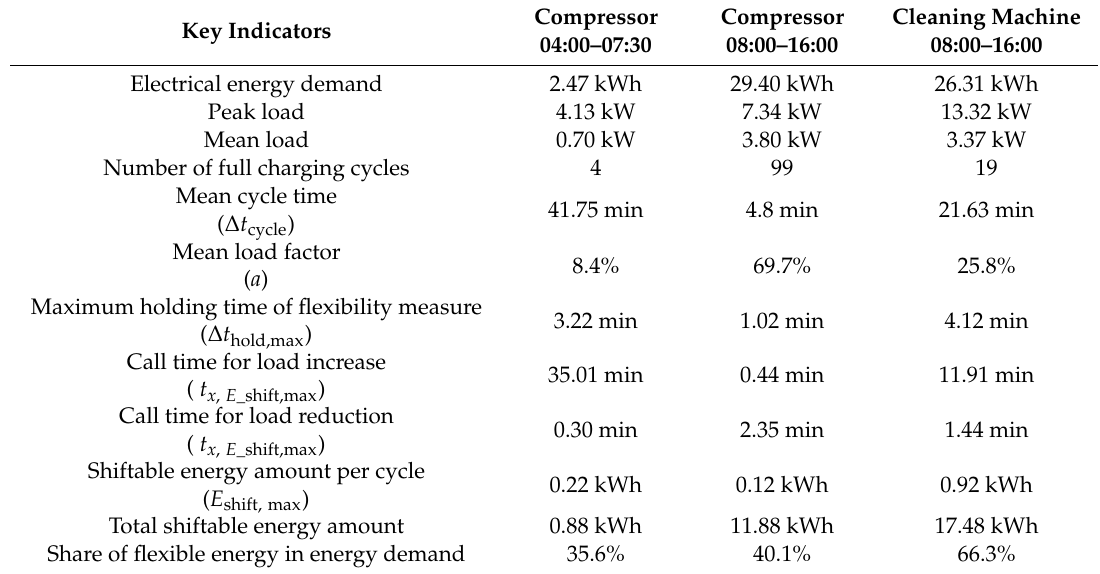
Table 3. Summary of the results of the case study (Step 1–5).